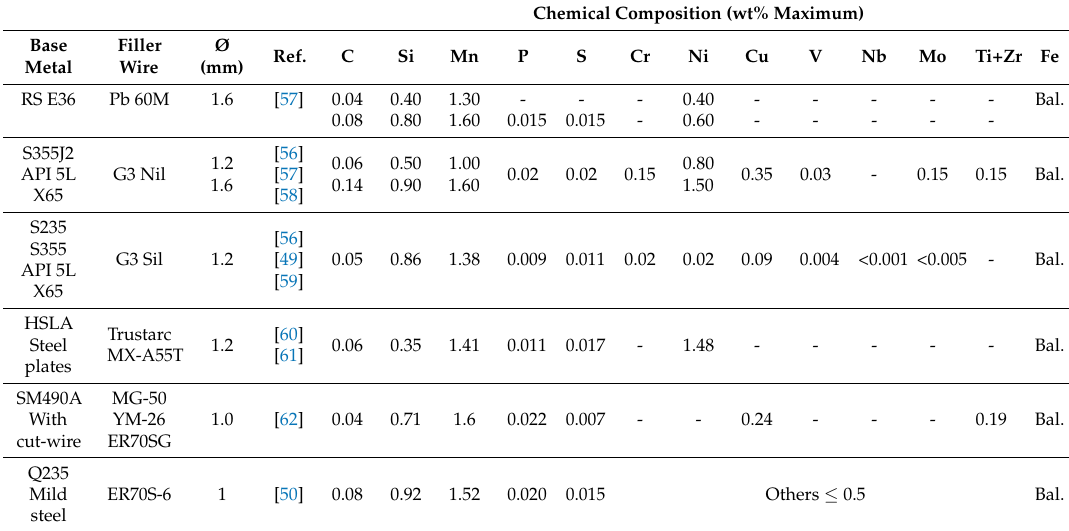
Table 6. Chemical composition of the welding wires.